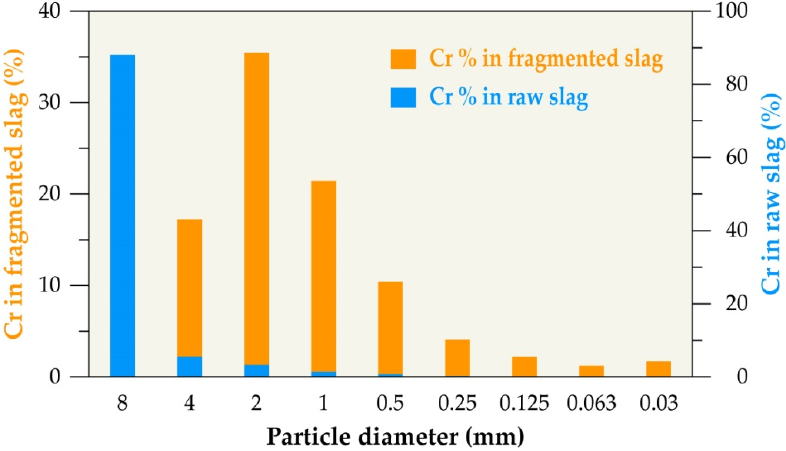
Figure 3. Chromium distribution in different particle size fractions of raw and fragmented slag. The vanadium content is further accumulated in a coarse size fraction of raw slag ( − 8/+4 mm) and distributed into three main size fractions of − 4/+2, − 2/+1, and − 1/+0.5 mm representing 45%, 25%, and 15%, respectively, of the fragmented slag, as shown in Figure 4.